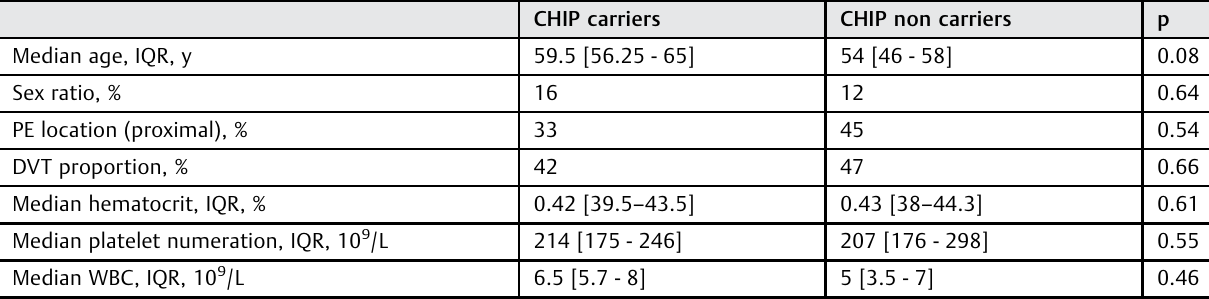
Table 2 Comparison between CHIP carriers and non carriers